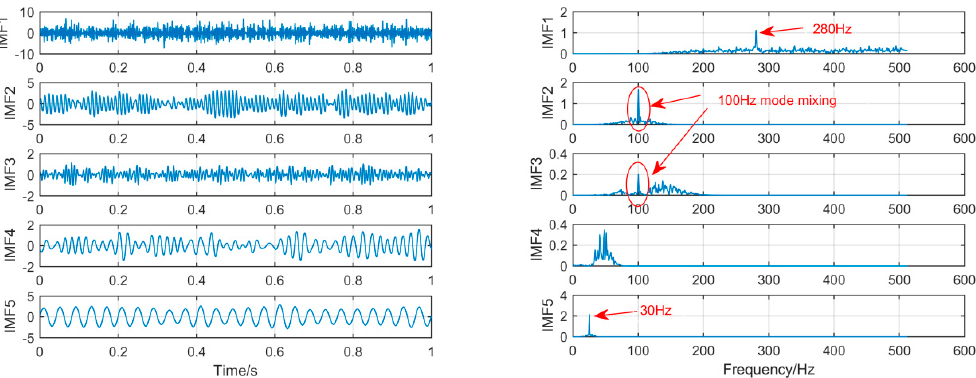
Figure 4. The spectrum of IMFs after SSD and its corresponding spectrum.